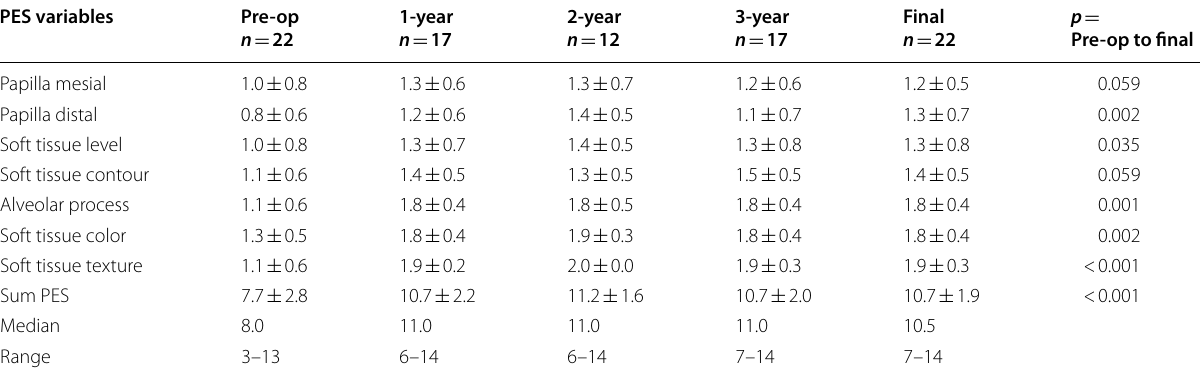
Table 3 Mean score ( SD) of the variables of the PES according to Fürhauser during the observation period ± PES